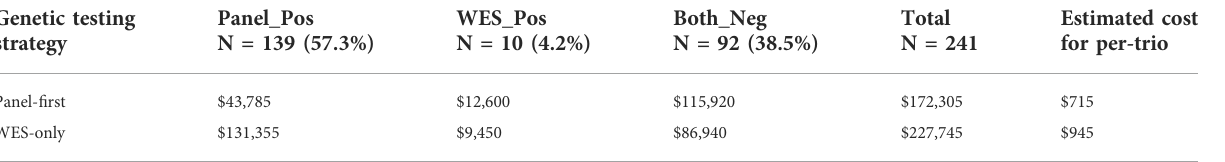
TABLE 4 Cost estimation for two genetic testing strategies. Genetic testing